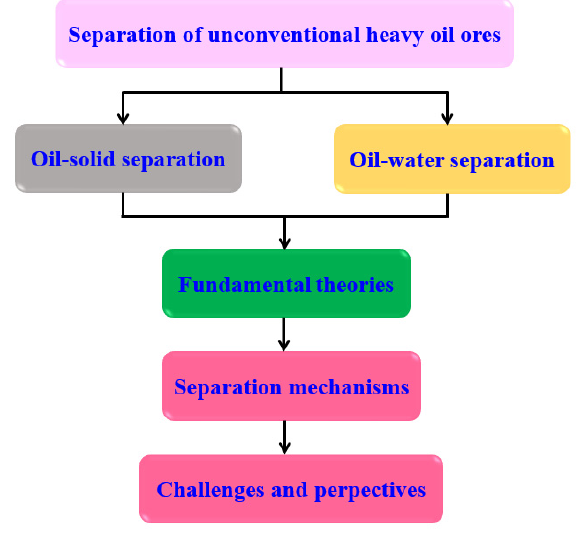
Figure 6. The review logical structure.